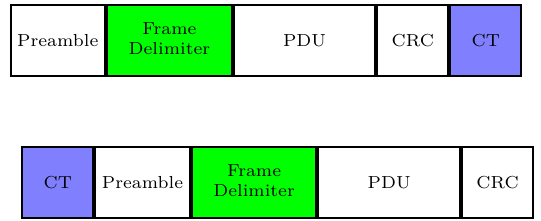
Figure 1: Frame format description. Top: from verifier to prover. Below: from prover to